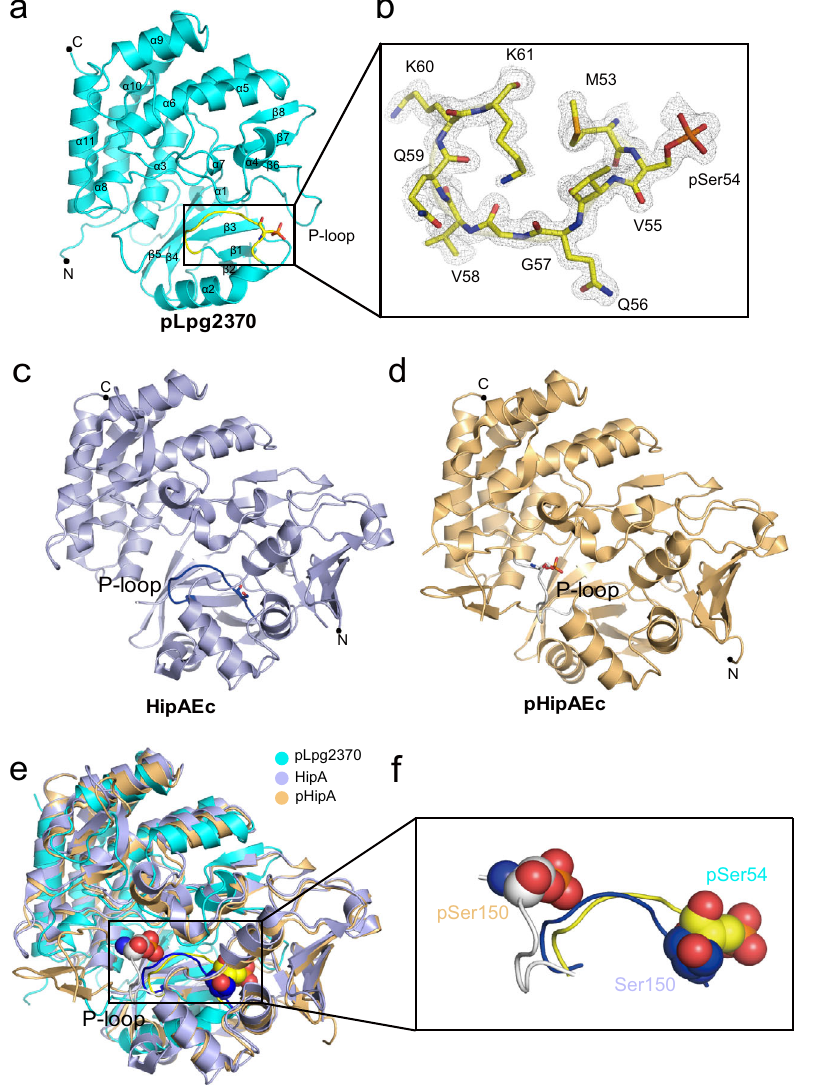
Fig. 2 | Crystal structure of pLpg2370. a Cartoon representation of pLpg2370. The N- and C-termini of pLpg2370 and its secondary elements of are labeled correspondingly. The P-loop is colored yellow and the pSer54 is shown in stick representation. b DetailedviewoftheP-loopwiththepSer54.The2Fo-Fcomitmap is contoured at the 1.0 σ level and the P-loop residues are labeled. Crystal struc- tures of the unphosphorylated HipA Ec (PDB ID: 3TPB) ( c ) and pHipA Ec (PDB ID: 3TPE) ( d ). The P-loops are labeled on both structures and colored blue and white,